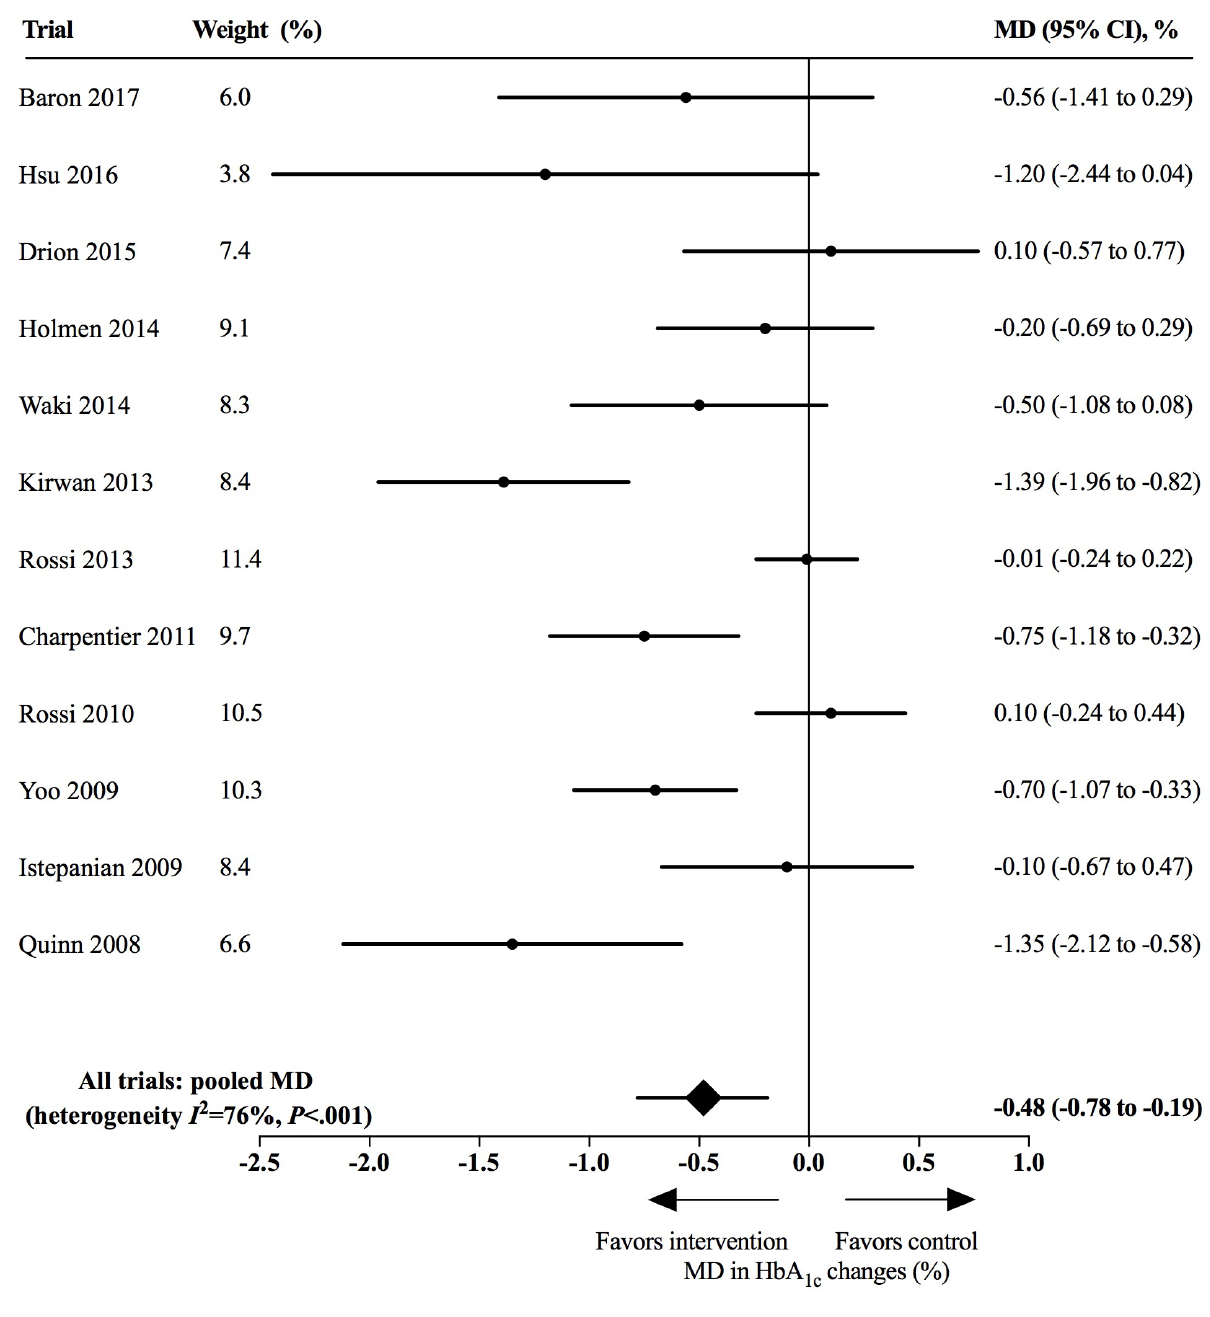
Figure 4. Effects of app-based mobile health interventions on hemoglobin A 1c (HbA 1c ). MD: mean